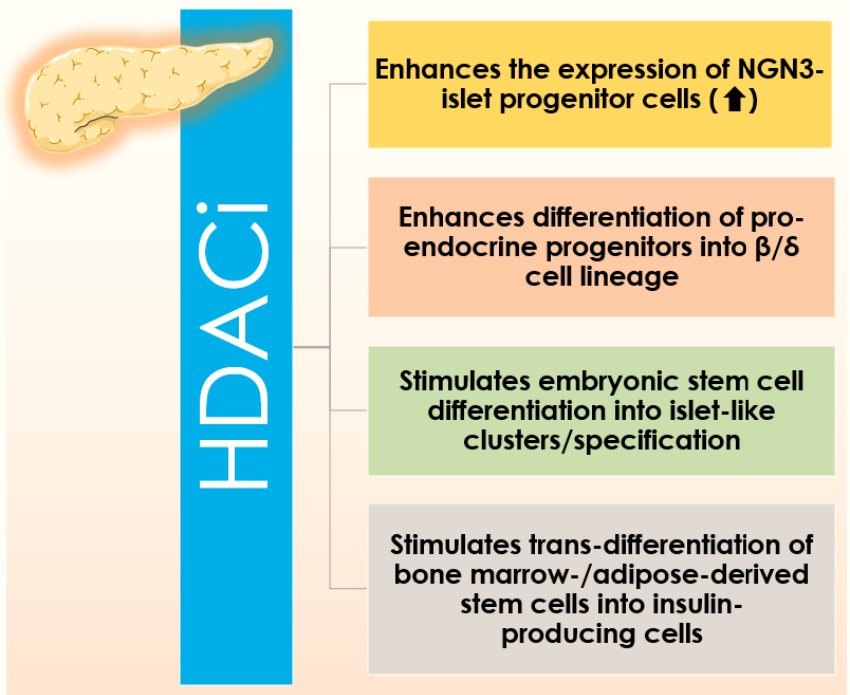
Figure 1. Figure showing different biological activities of HDAC inhibitors (HDACis) that promote the expression of NGN3 and islet progenitor cell numbers, their differentiation into the β/δ cell lineage, embryonic stem cell differentiation into islet-like clusters/specification, and trans-differentiation of bone marrow-/adipose-derived stem cells into insulin-pro- ducing